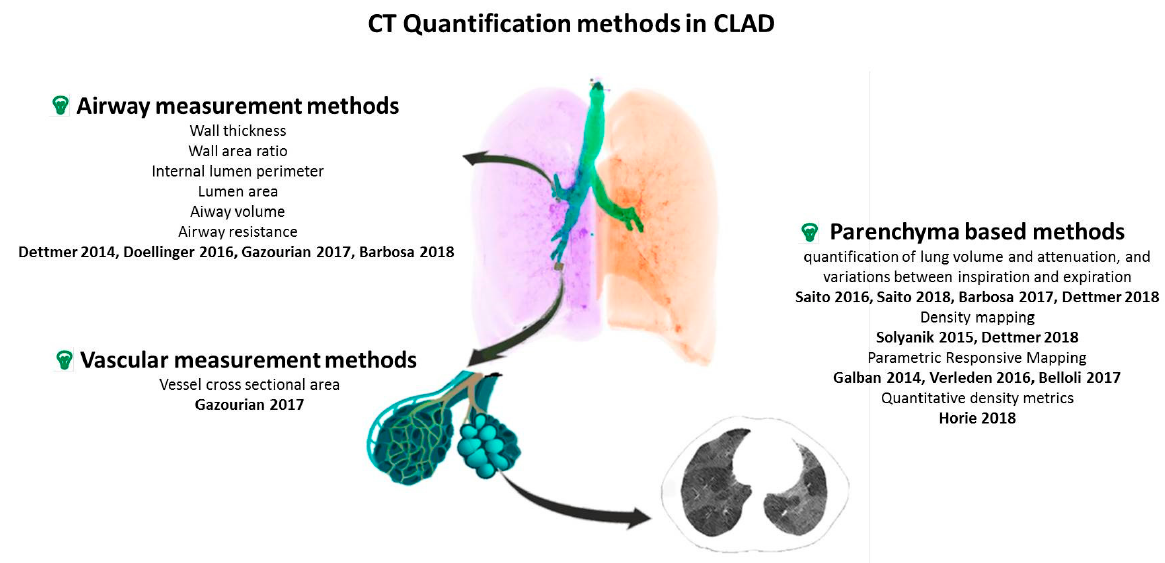
Figure 1. Overview of CT quantification methods for CLAD. CT: computer tomography, CLAD: chronic lung allograft dysfunction. Airway measurement methods [8,9,12,14], Vascular measurement methods [14], Parenchyma based meth- ods [10,11,15–21]